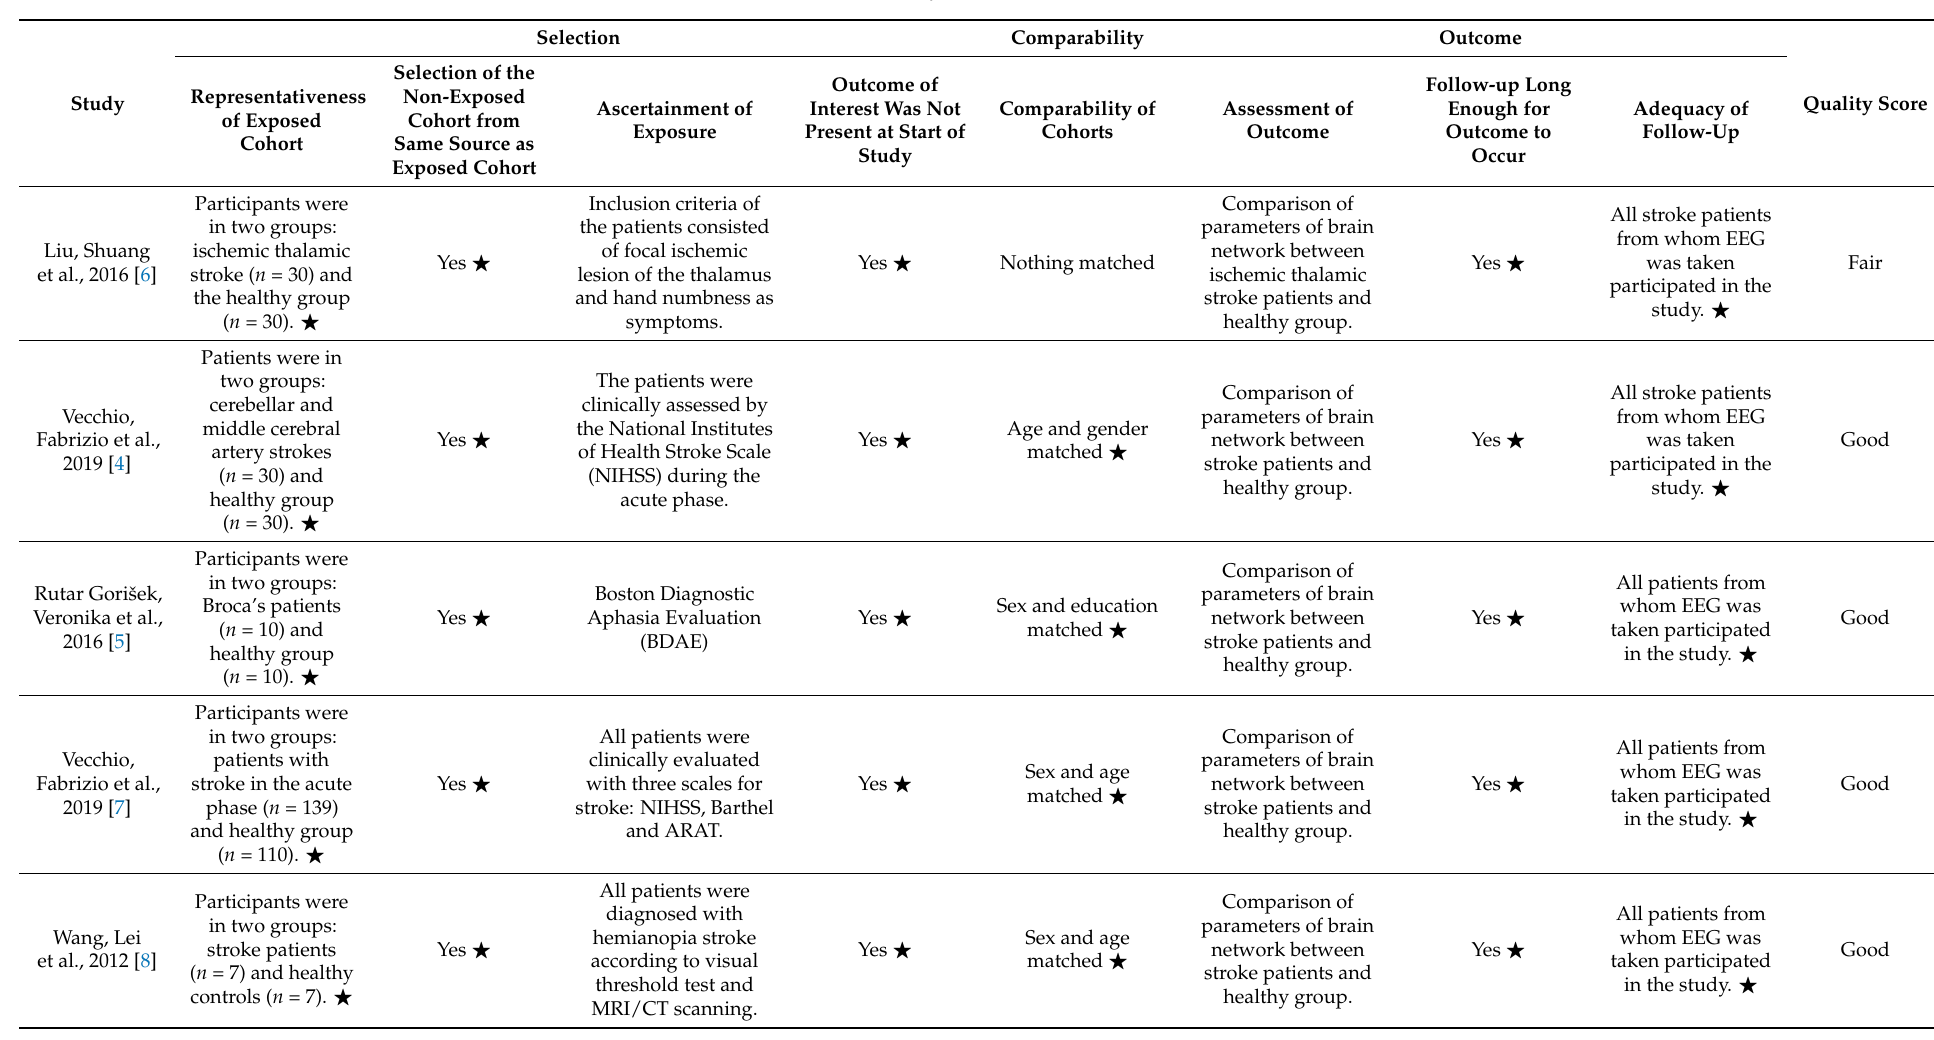
Table 2. Risk of bias assessment (Newcastle–Ottawa Quality Assessment Scale criteria).